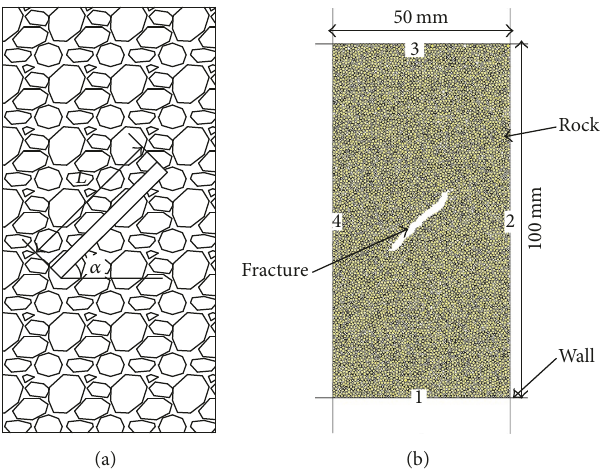
Figure 4: Fractured rock sample (a) and numerical model implemented in PFC (b).